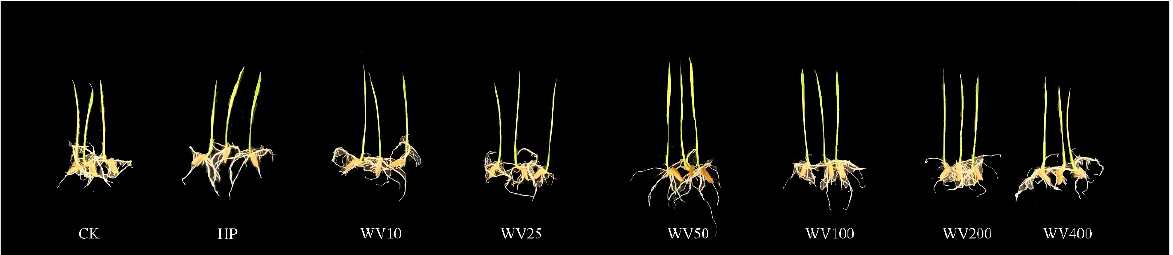
Figure 1. Pictorial illustration of different concentrations of WV treated rice seedlings at 7 DAS un- der growth chamber experiment. CK: untreated seeds, HP: hydro-priming. Numbers after WV de- note the WV concentration used for seed